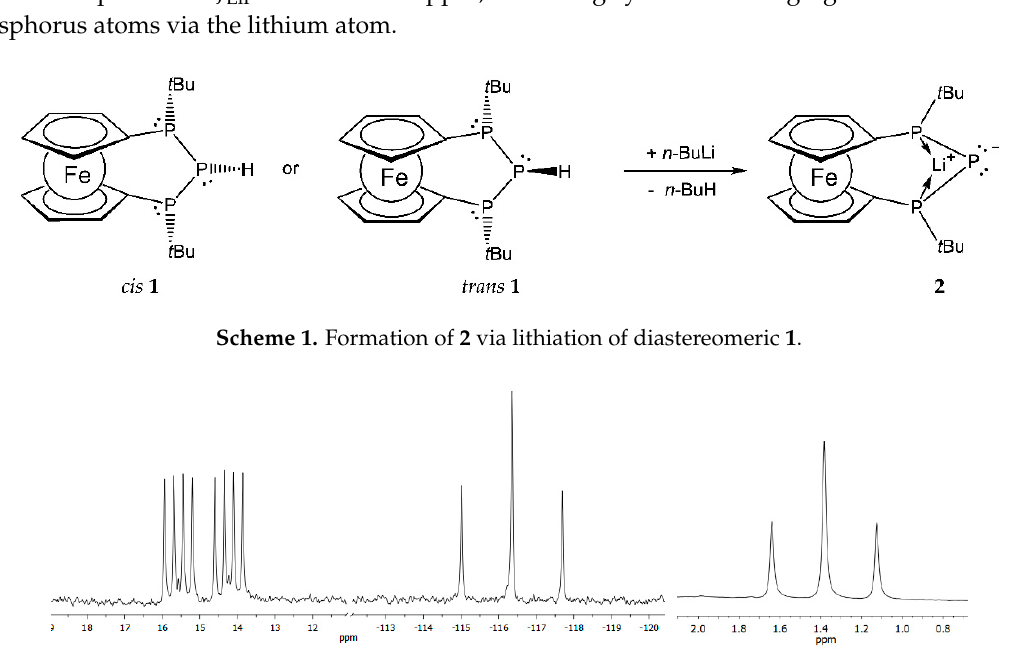
Figure 1. Expansion from the 31 P (( left ) and ( mid ), 202 MHz) and 7 Li (( right ), 194 MHz) NMR spectra of 2 (Scheme 1) in benzene-d 6 solution at room temperature.